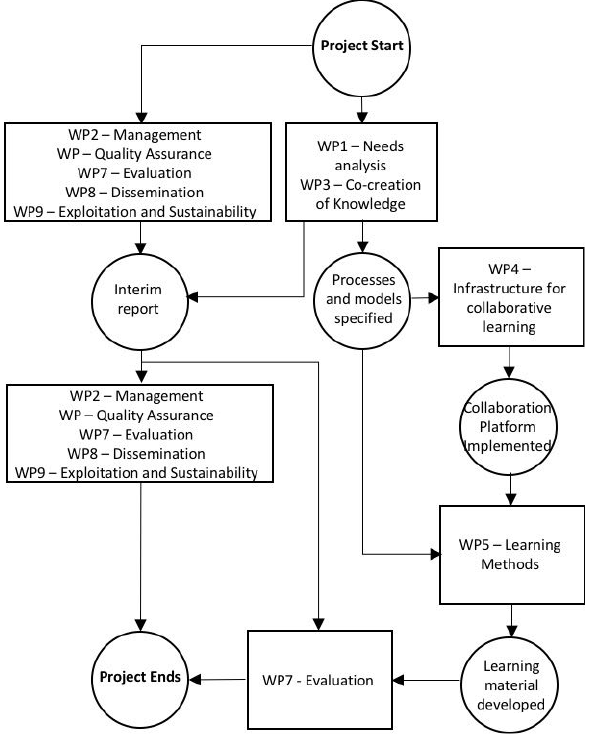
Figure 1. Representation of the giCASES